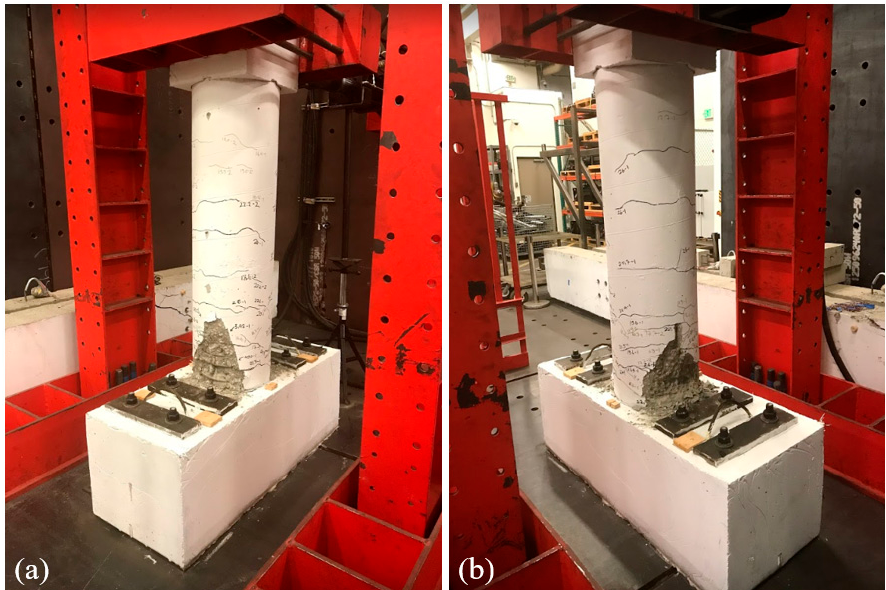
Figure 7. Column condition after testing ( a ) East and ( b ) West view.